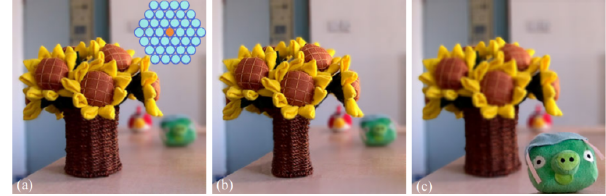
Fig. 7 Results of reshuffling and re-layering the content in a light field using PlenoPatch [53]. Reproduced with permission from Ref. [53], c (cid:13) IEEE 2016.